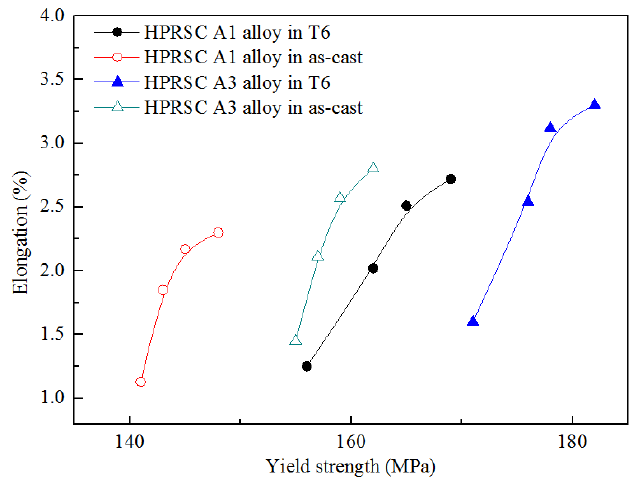
Figure 17. Plot of yield strength (YS) versus elongation of HPRSC A1 and A3 alloys.